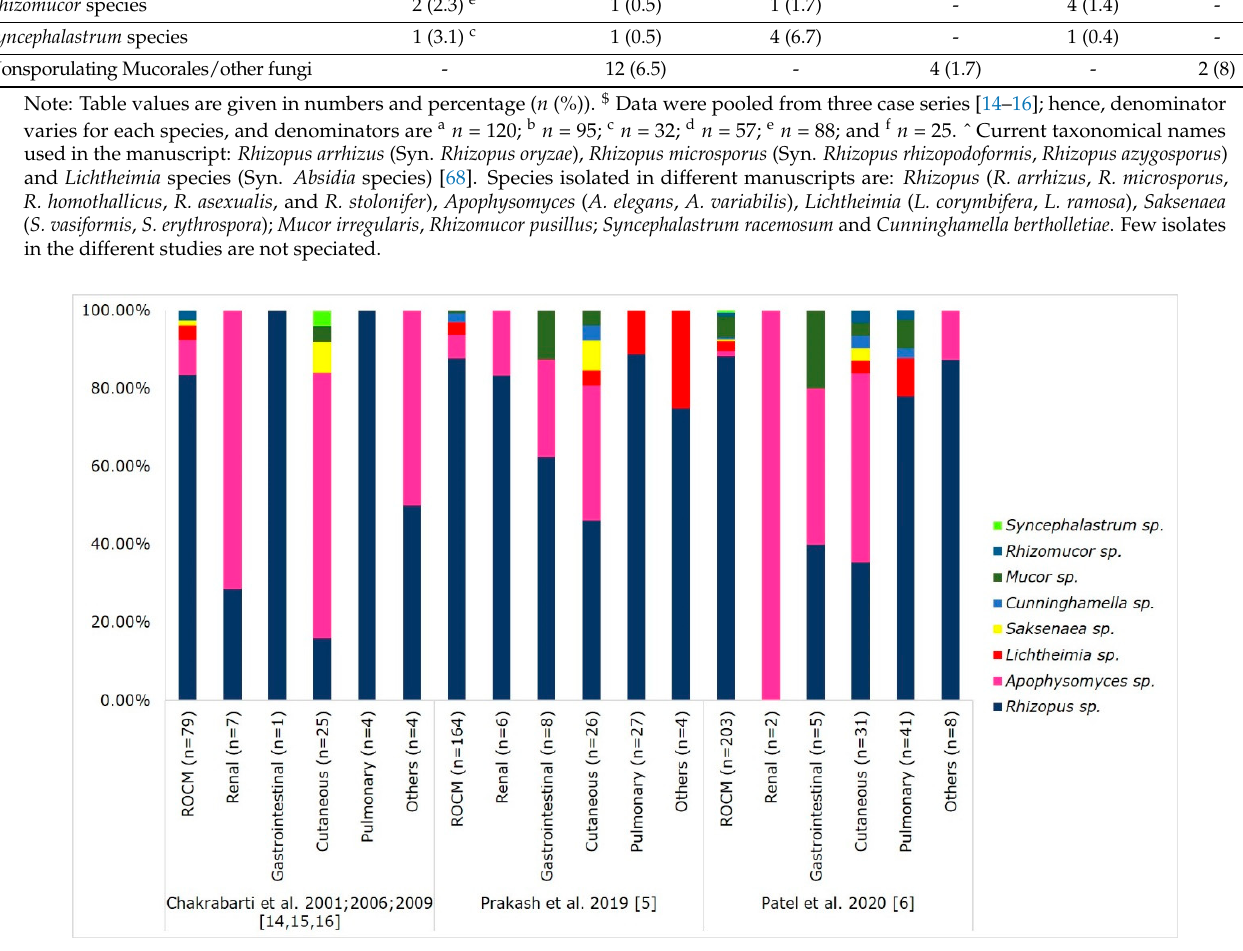
Figure 3. Mucorales spectrum associated with clinical forms of mucormycosis. Abbreviations: ROCM, rhino-orbital-cerebral mucormycosis. Others included mucormycosis of oral cavity, otitis media, subglottis, bones, and disseminated infections.